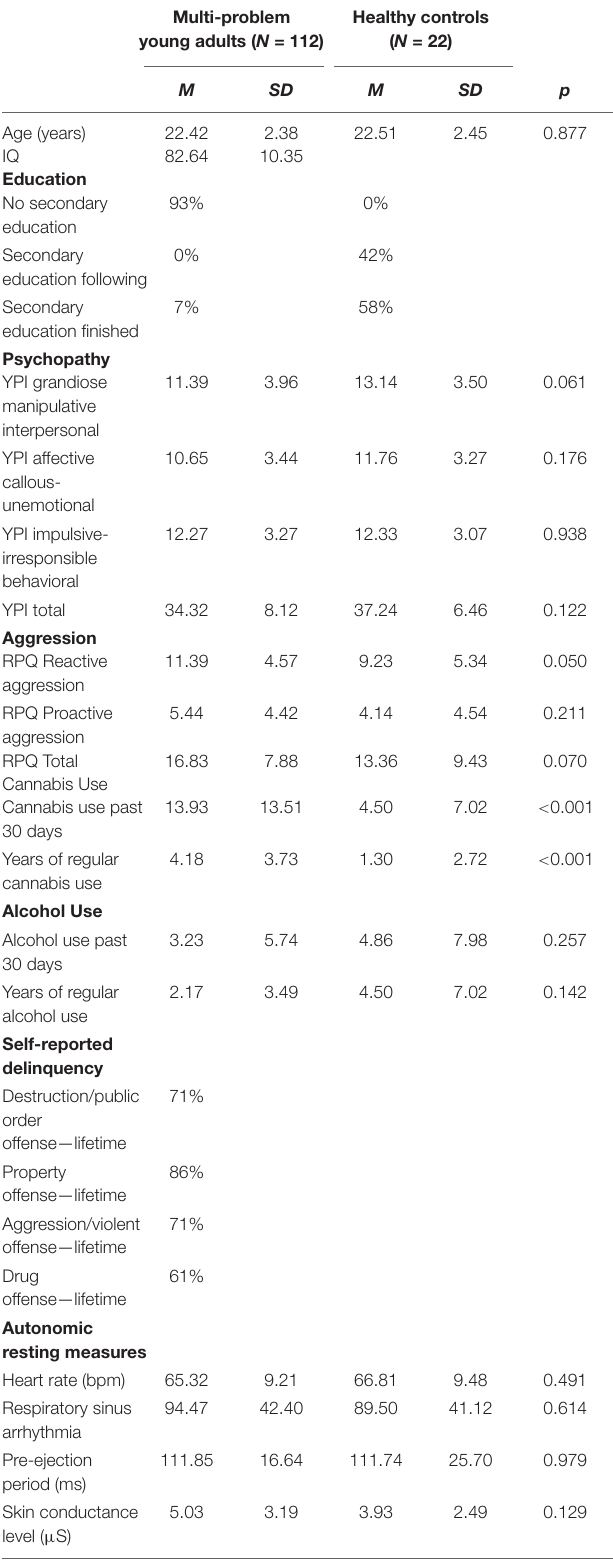
TABLE 1 | Questionnaire and autonomic baseline measures. Multi-problem young adults ( N =